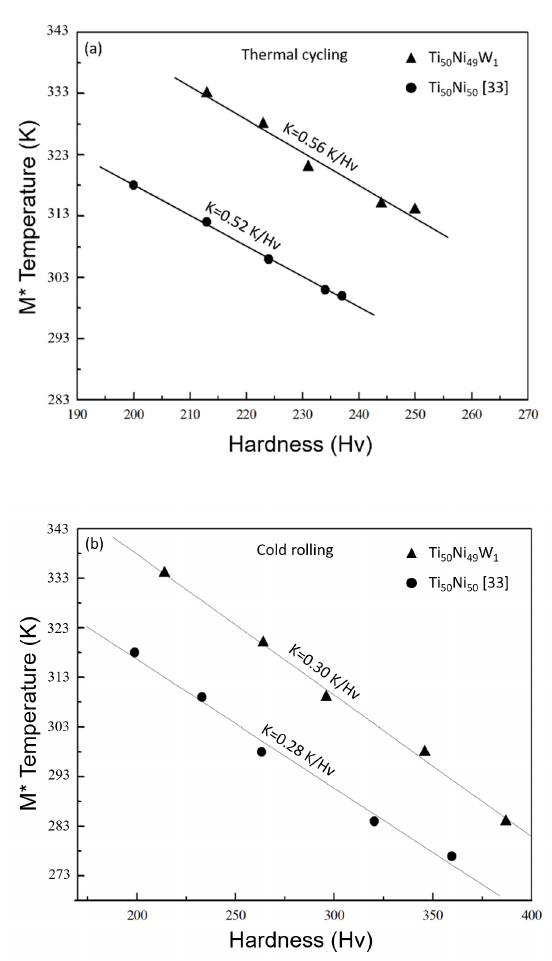
Figure 9. M * temperature versus hardness of Ti 50 Ni 50 [33] and Ti 50 Ni 49 W 1 alloys after ( a ) thermal cycling and ( b ) cold rolling.